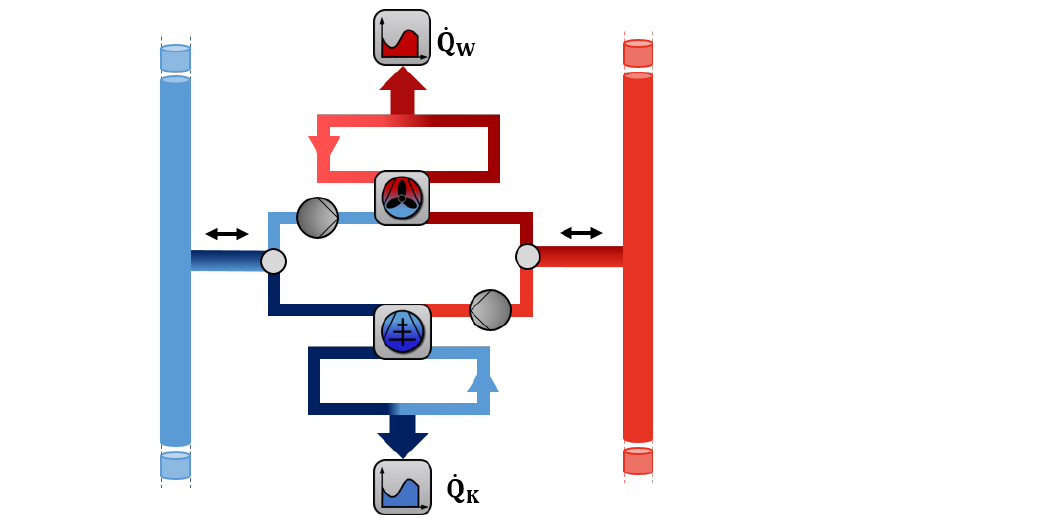
Figure 6. Schematic illustration of a 5GDHC substation with heat pump, chiller, and decentralized distribution